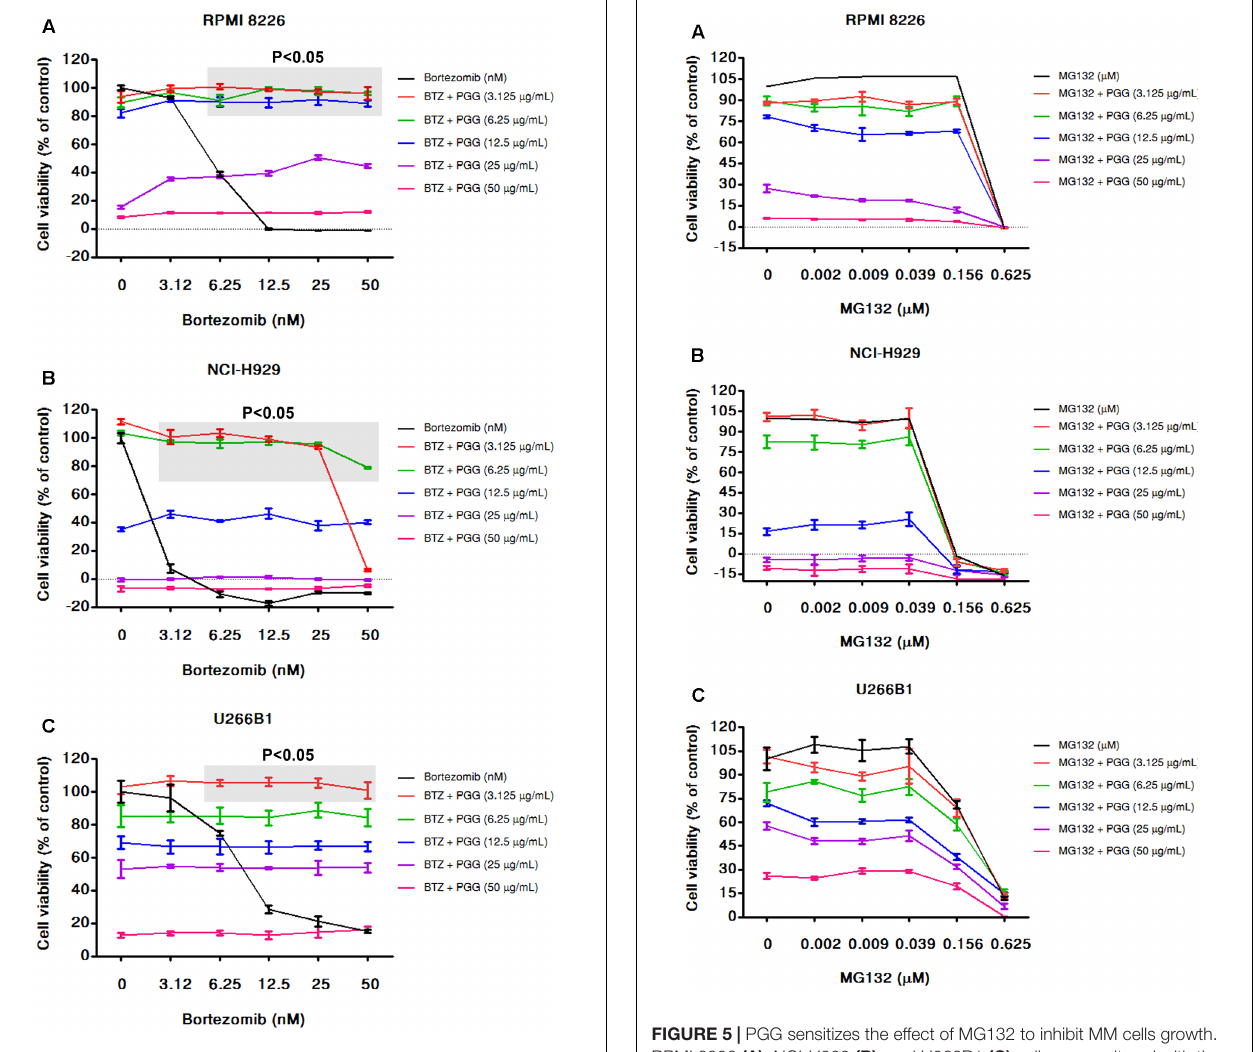
FIGURE 4 | PGG neutralizes the effect of bortezomib in MM cells. RPMI 8226 (A) , NCI-H929 (B) , and U266B1 (C) MM cells were treated with various dosages of PGG (3.125–50 µ g/mL) and bortezomib (3.125–50 nM) both alone and in combinations. After 72 h cell viability was assessed by alamarBlue R (cid:13) assay as mentioned in Section “Materials and Methods.” The percentage of viable cells normalized to solvent treated control cells were plotted after background subtraction. The light gray boxes with ( P < 0.05) represents that the low doses of PGG significantly antagonizing the effect of bortezomib on cell viability. Results are means ± SD ( n = 3).